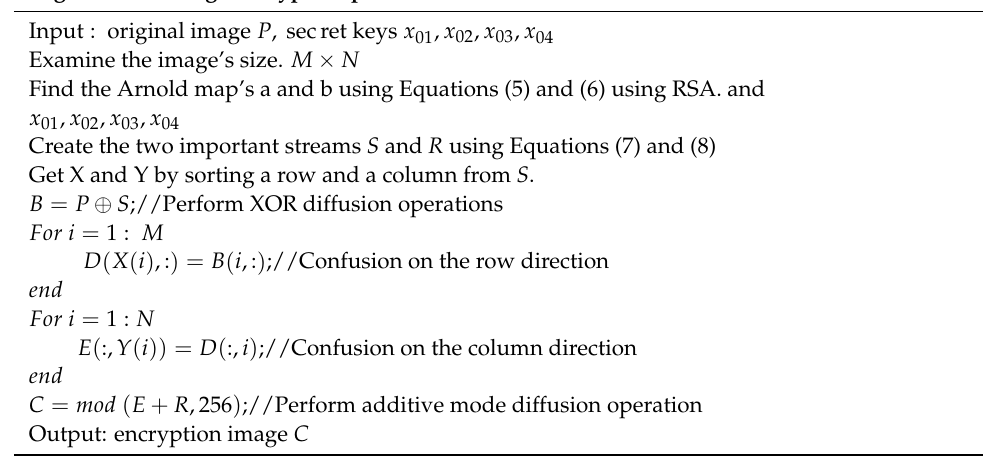
Algorithm 1: Image encryption